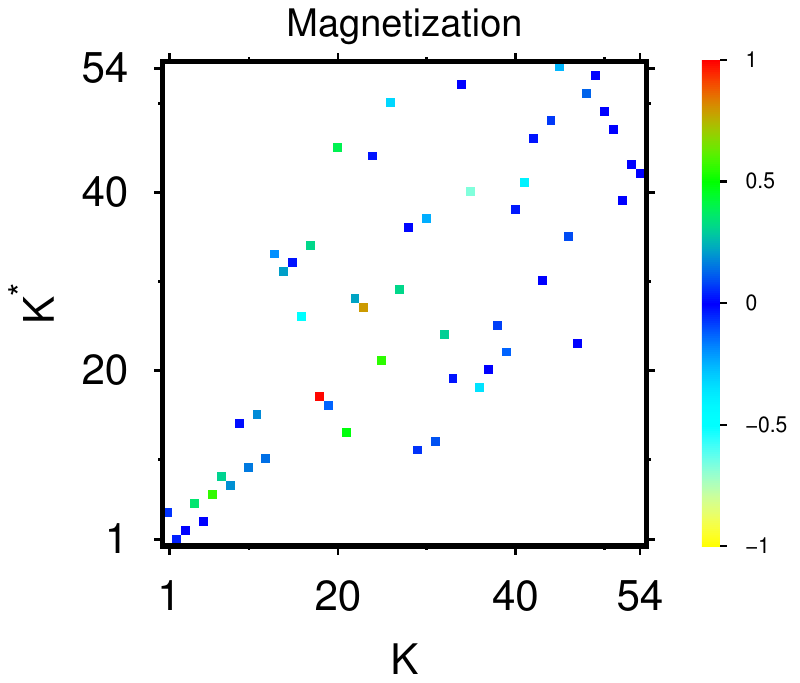
Figure 7. PageRank “magnetization” M ( j ) = ( P + ( j ) − P − ( j )) / ( P + ( j ) + P − ( j )) of proteins of Table 1 shown on the PageRank–CheiRank plane ( K , K ∗ ) of local indices; here, j represents a protein node in the initial single protein network and P ± ( j ) are the PageRank components of the bifunctional Ising MetaCore network (see text). The values of the color bar correspond to M / max | M | with max | M | = 0.690937 being the maximal value of | M ( j ) | for the shown group of proteins. Note that the positions in the PageRank–CheiRank plane are identical to the positions of Appendix A Figure A1, and the corresponding K , K ∗ values are given in the third and fourth column of Table